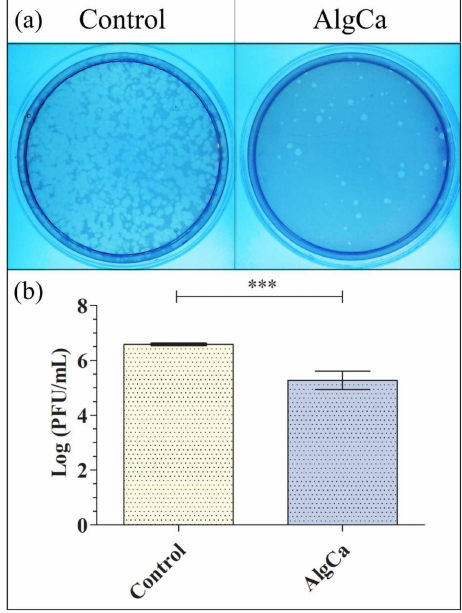
Figure 3. Antiviral activity of calcium alginate against bacteriophage phi 6 determined by the double- layer method: ( a ) Titration images (undiluted samples) for AlgCa film and control after 30 min of viral contact. These images show the reduction in infection capacity (reduction in lighter spots); ( b ) Viral inactivation in log (PFU/mL) for AlgCa film and control after 30 min of viral contact. Student’s t -test (*** p >